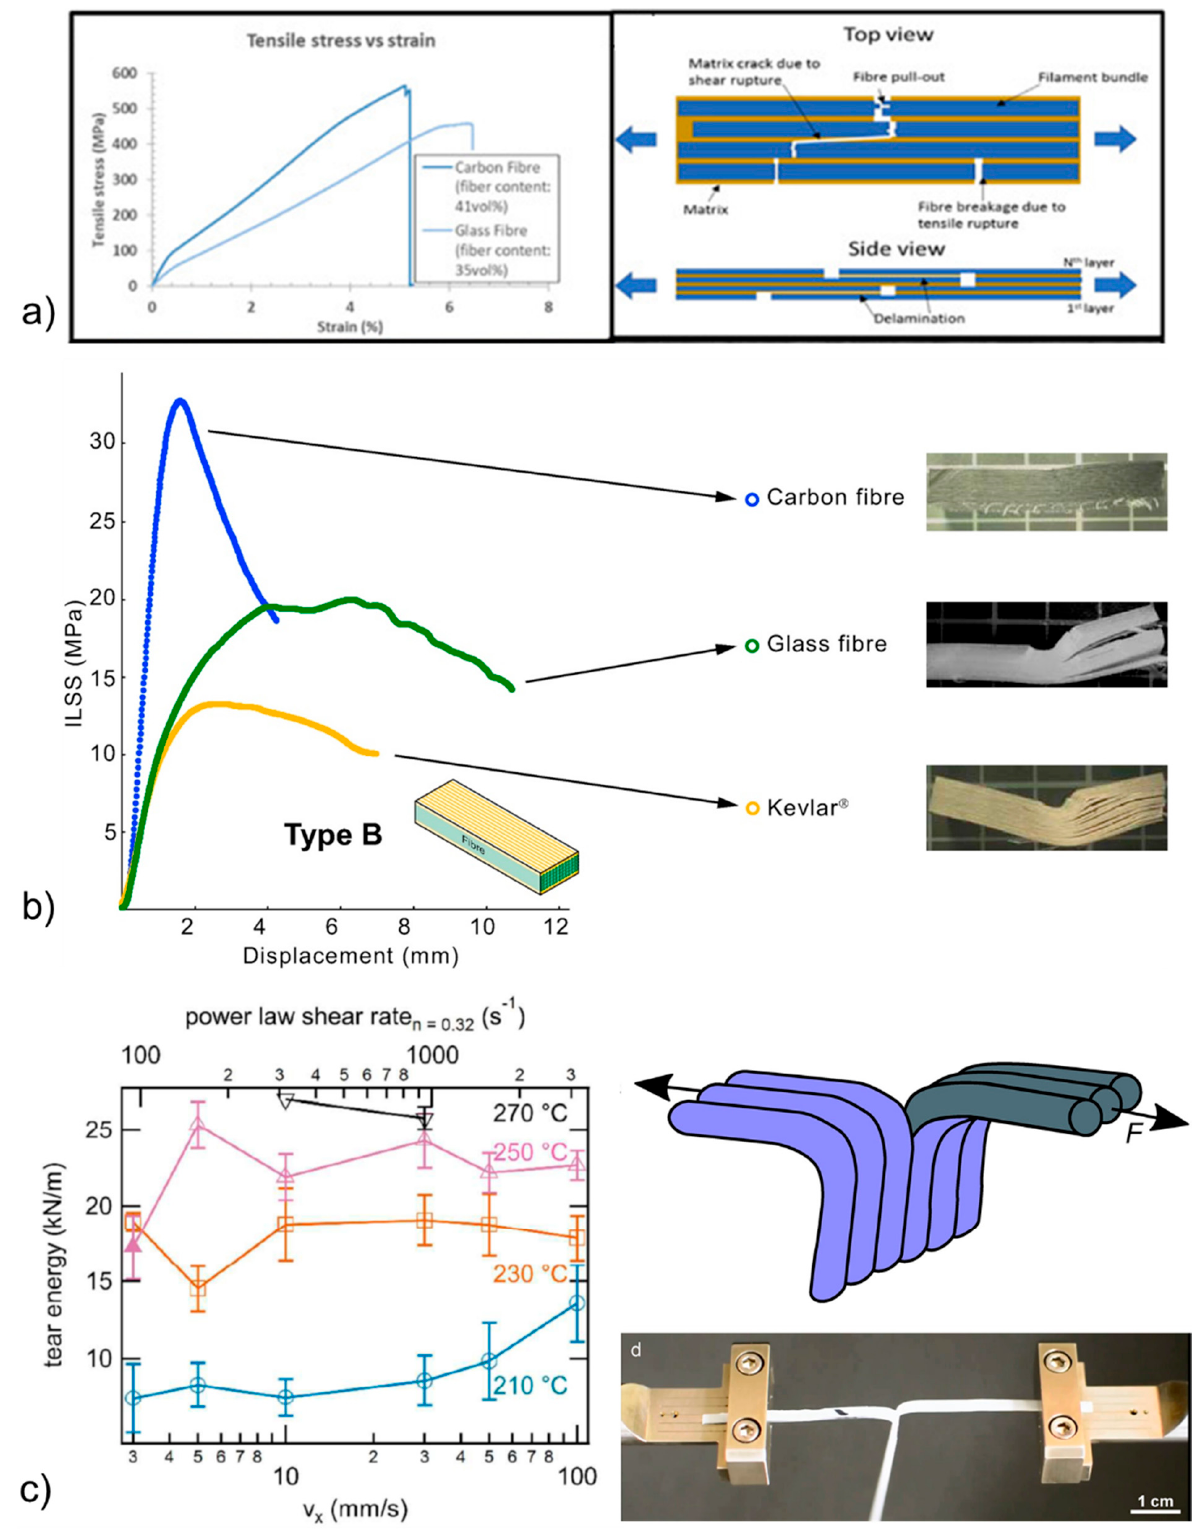
Figure 4. Main mechanical testing of 3D printed neat TPs and CFRTPCs: ( a ) tensile testing of 0° UD laminate composite (PA with carbon or glass fibers) [29] (copyright (2018), with permission from Elsevier), ( b ) short beam shear (SBS) testing to measure the interlaminar shear strength (ILSS) of glass and Kevlar fiber-reinforced PA, [31] (copyright (2018), with permission from Elsevier), and ( c ) welding line adhesion measured by “trouser tear” Mode III fracture testing in the case of neat acrylonitrile butadiene styrene (ABS) [24,33] (copyright (2017), with permission from the Royal Society of Chemistry and Elsevier).